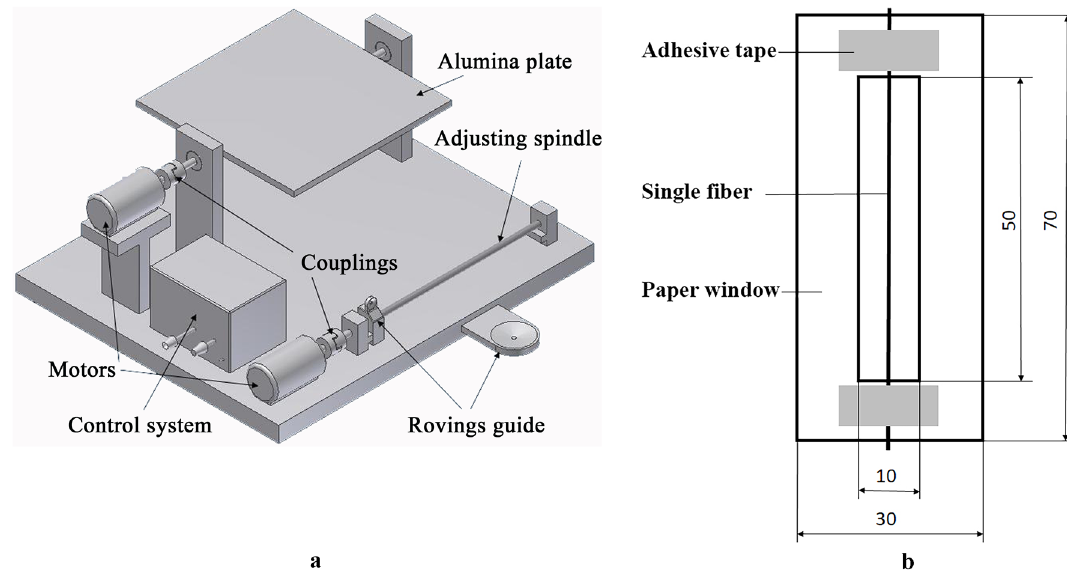
Figure 1. Winding unit ( a ) and fiber preparation ( b